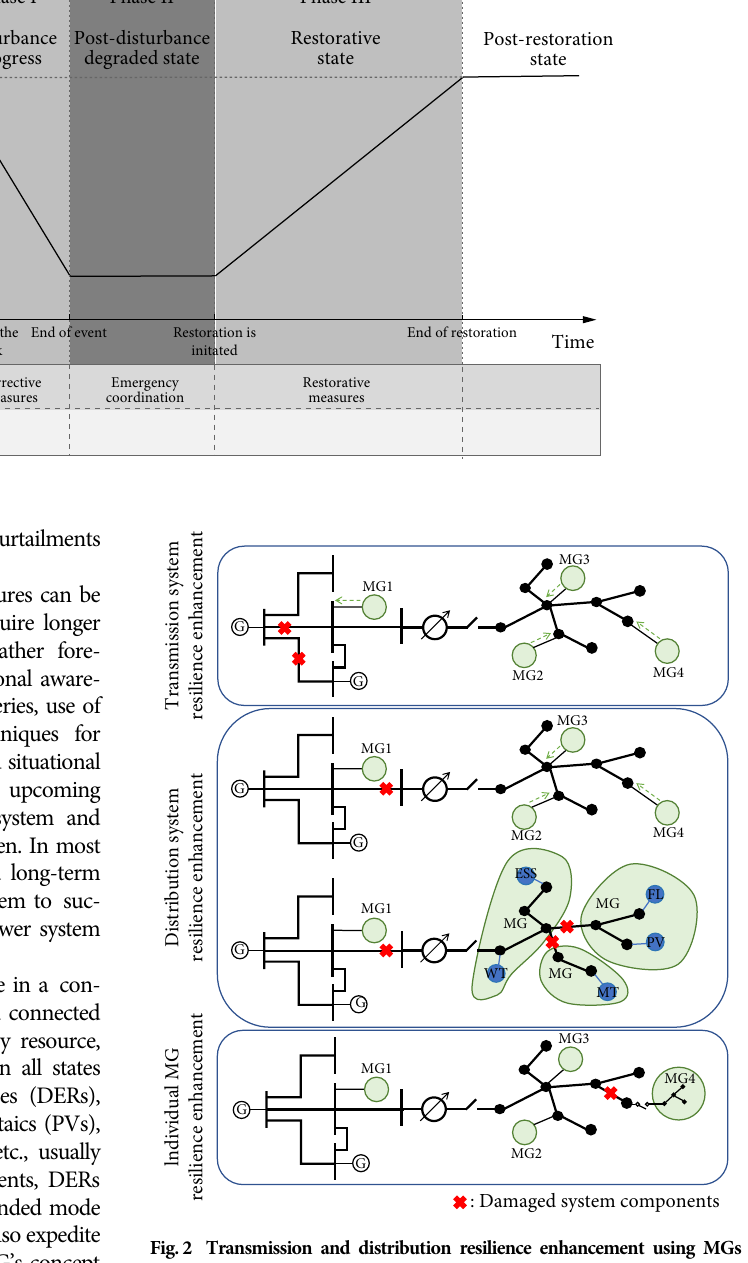
Fig. 2 Transmission and distribution resilience enhancement using MGs and individual MG resilience